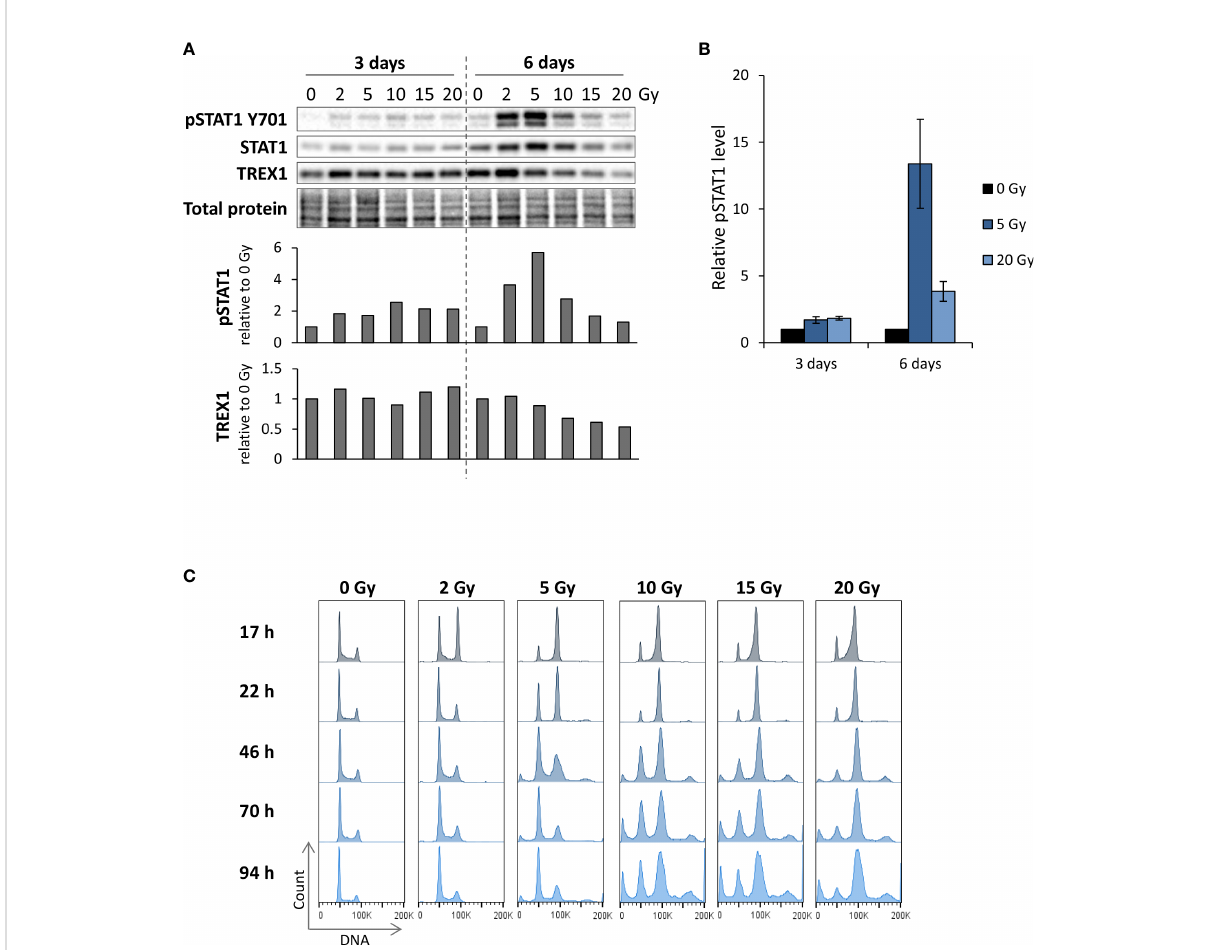
FIGURE 1 Reduction of radiation-induced IFN signaling at high IR doses coincides with prolonged G2 checkpoint arrest. (A) Immunoblots of U2OS cells harvested at three and six days after IR. Bar charts show pSTAT1 and TREX1 levels relative to total protein and normalized to mock. (B) Quanti fi cation of pSTAT1 levels relative to the corresponding mock sample for multiple independent experiments with 5 and 20 Gy as in (A) . (3 days: n = 5 for 5 Gy and n = 4 for 20 Gy; 6 days: n = 3) (C) DNA histograms from parallel samples in the same experiment as in (A) . The ‘ 100K ’ annotation marks the G2/M phase peak. Results in (A, C) are representative for three independent experiments performed at different time points within 0-6 days post